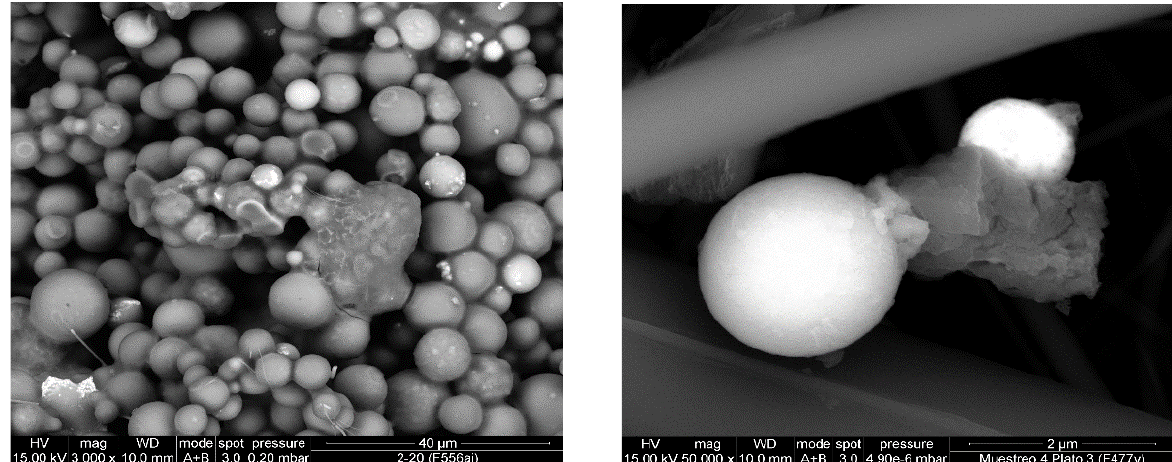
Figure 9. SEM photograph of the PM emitted in the frit melting stage.